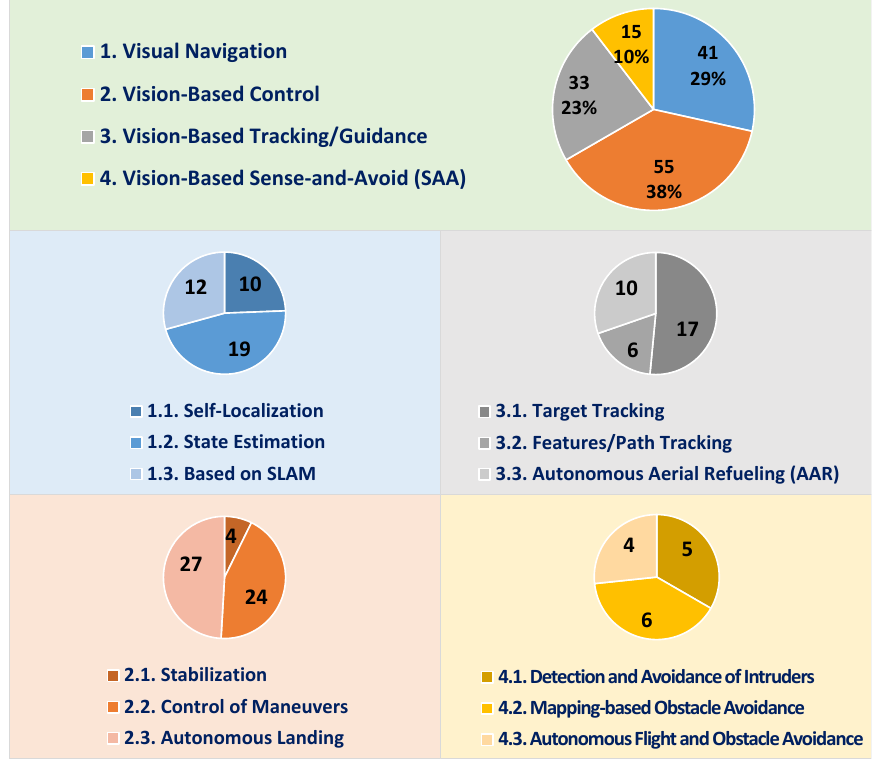
Figure 9. Category distribution over the